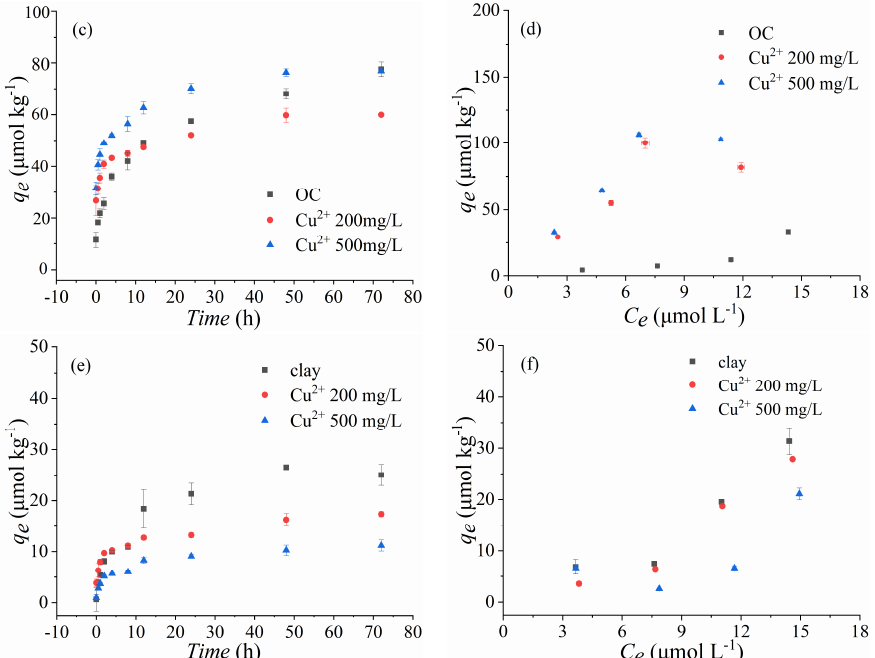
Figure 2. The sorption kinetics (a,c,e) and isotherms(b,d,f) of SDZ in the crude soil, organic particles, and clay with Cu 2+ co-existing in the soil solution. Table 4. Fitting results of kinetics data to pseudo-first and pseudo-second-order equations for SDZ adsorption on soil composition. Treatments